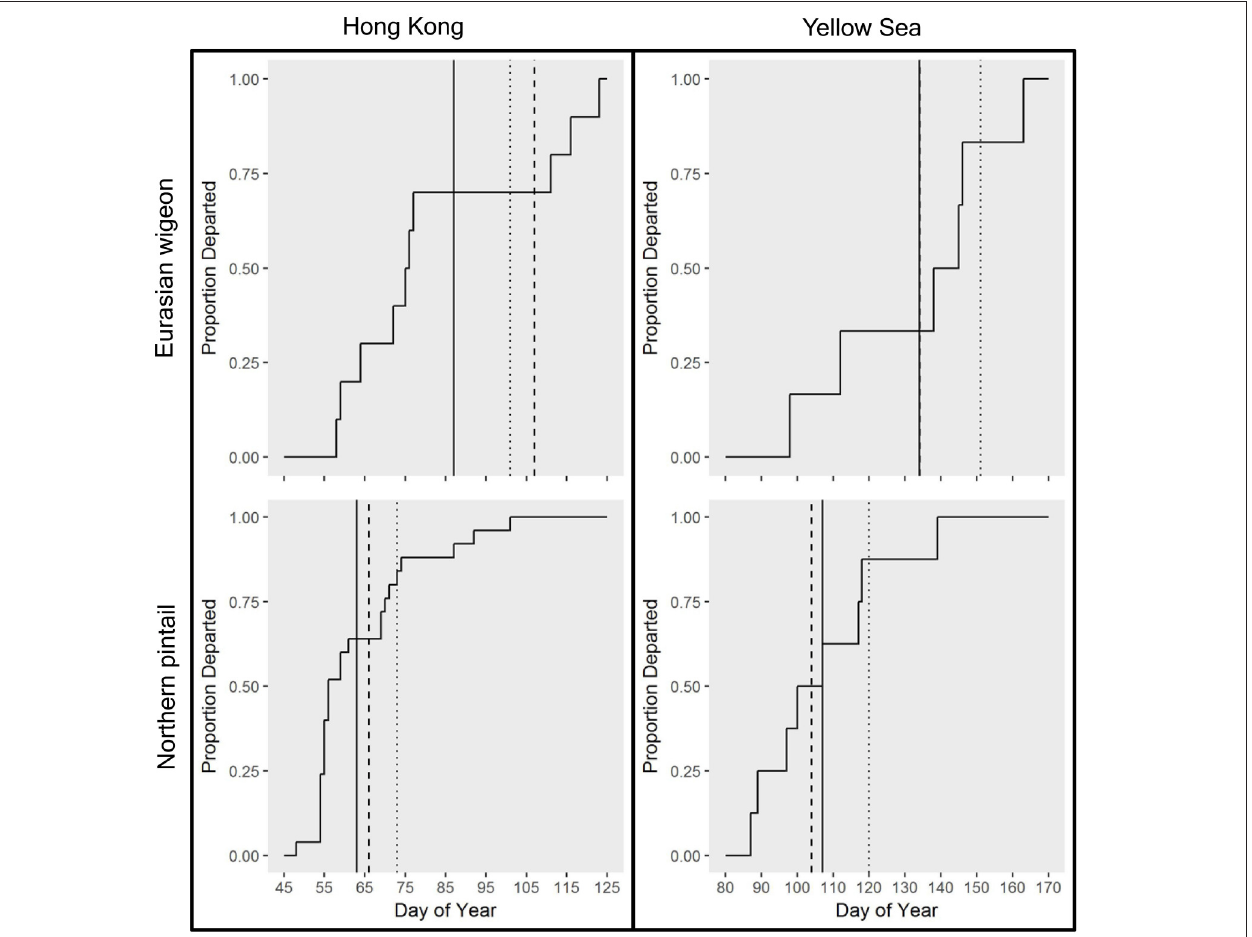
FIGURE 1 | Mean spring initiation migration date and date of departure from the Yellow Sea region for Eurasian wigeon marked at Mai Po Nature Preserve in Hong Kong China from 2008 to 2009. Means were determined for intermediate-distance migrants (dotted lines), and long-distance migrants (dashed lines), and all birds combined (solid